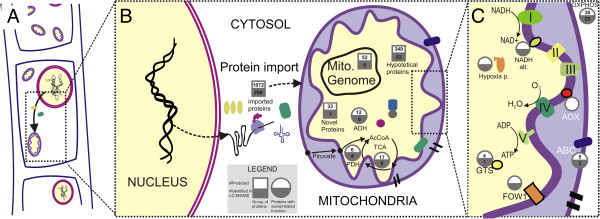
Schematic summary of the C. cacaofunesta mitochondrial proteome survey. (A) Detailed representation of a hypha, including the nucleus and the mitochondria. (B) Nuclear – mitochondrial communication represented by the protein import (predicted/identified by LC-MS/MS). In the mitochondria are represented proteins involved in pyruvate dehydrogenase complex (PDH) and tricarboxylic acids cycle (TCA). Also, are represented aldehyde dehydrogenase (ADH); hypothetical proteins; novel proteins and proteins encoded in mtDNA. (C) Zoom of the mitochondrial subcompartments. Proteins involved in oxidative phosphorylation (OXPHOS) and polypeptides with probable role in pathogenicity are depicted. Cytochrome-dependent respiratory chain components (complexes I to V); alternative respiratory pathway including alternative NADH (NADH alt) and alternative oxidase (AOX); glutathione S-transferases (GST); ATP-binding cassette transporters (ABC) and protein homologous to mitochondrial carrier of Fussarium oxysporum (FOW1).